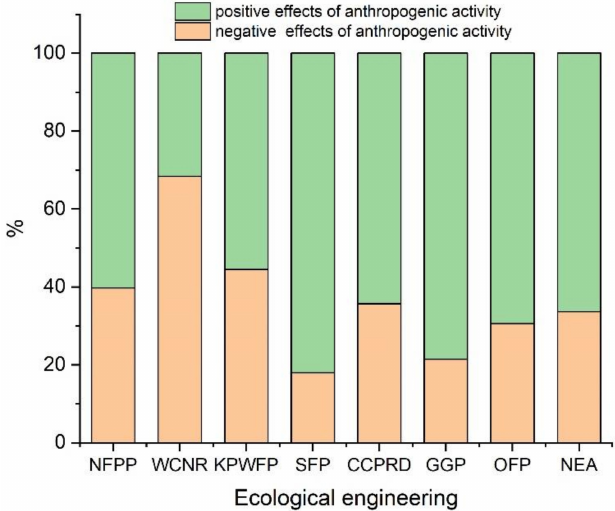
Figure 16. Proportion of areas of di ff erent ecological engineering projects with positive and negative e ff ects associated with anthropogenic